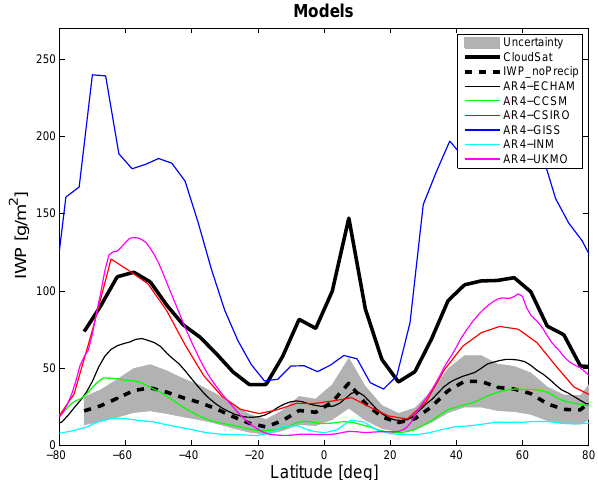
Fig. 3. Zonal averages of IWP for climate models from 100 years of monthly mean data. The uncertainty level is based on CloudSat data and applied to the IWP noPrecip dataset, as described in the text. A factor 0.5 is applied here to AR4-GISS in order to visualise it in the domain of this